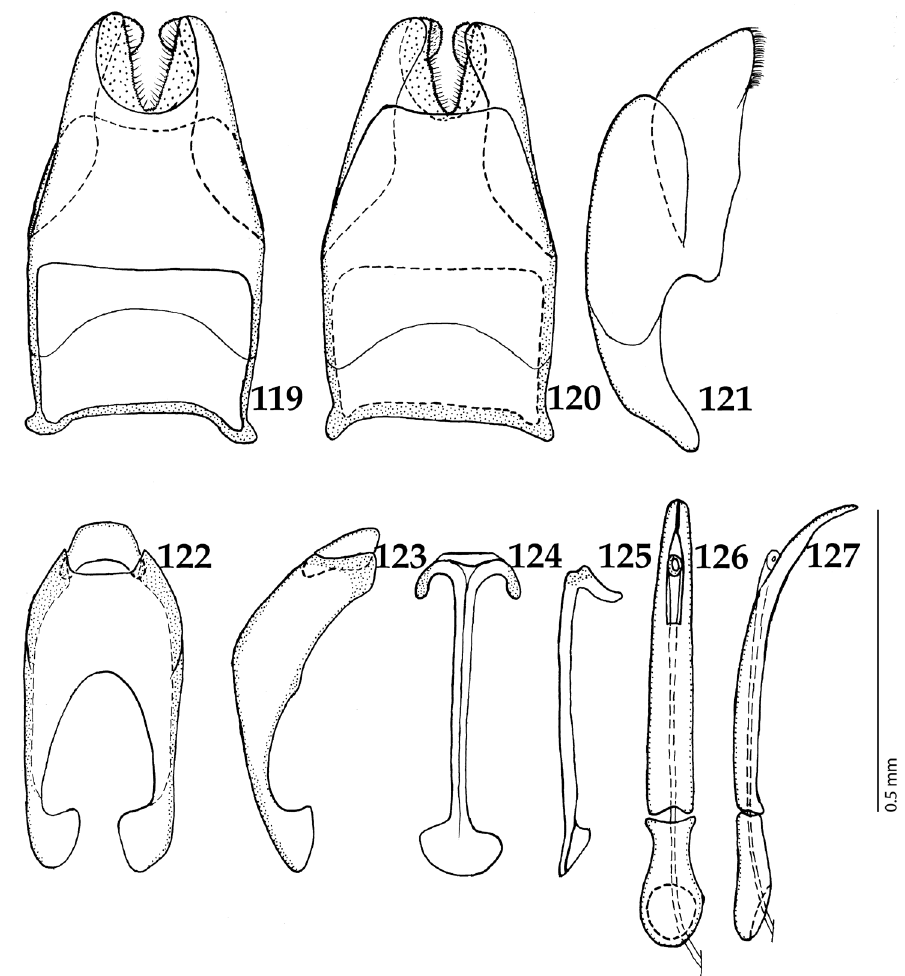
Figures 119–127. 119 Hypocacculus ( Hypocacculus ) hyla (Marseul, 1864) male terminalia: 8 th sternite + 8 th tergite, ventral view 120 ditto, dorsal view 121 ditto, lateral view 122 male terminalia: 9 th + 10 th ter- gites, dorsal view 123 ditto, lateral view 124 male terminalia: spiculum gastrale, ventral view 125 ditto, lateral view 126 male terminalia: aedeagus, dorsal view 127 ditto, lateral view.